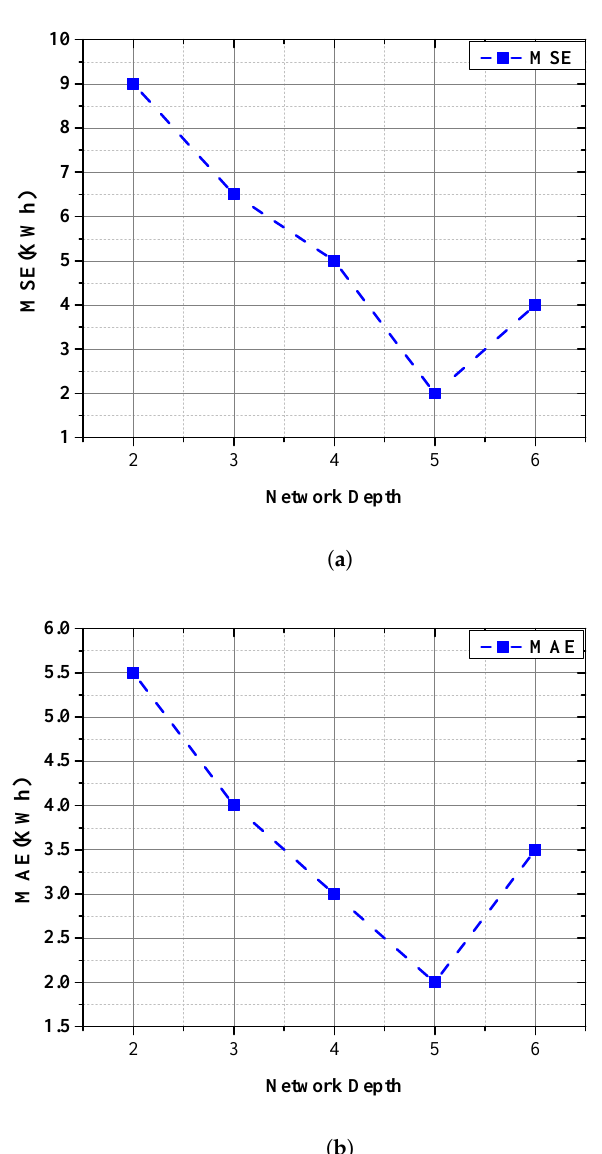
Figure 5. The metrics ( a ) MSE and ( b ) MAE for the QL model, adjusted for alterations in network depth. ( a ) MSE versus different network layers. ( b ) MAE versus different network